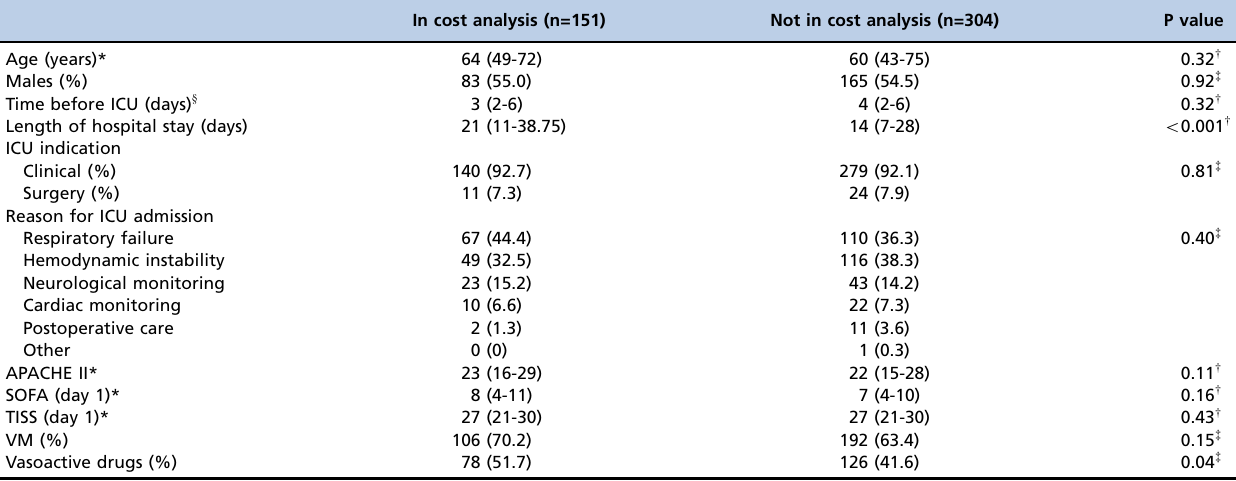
Table 2 - Comparison of demographic and clinical characteristics of the study patients who were or were not included in the analysis of direct costs. In cost analysis (n=151)